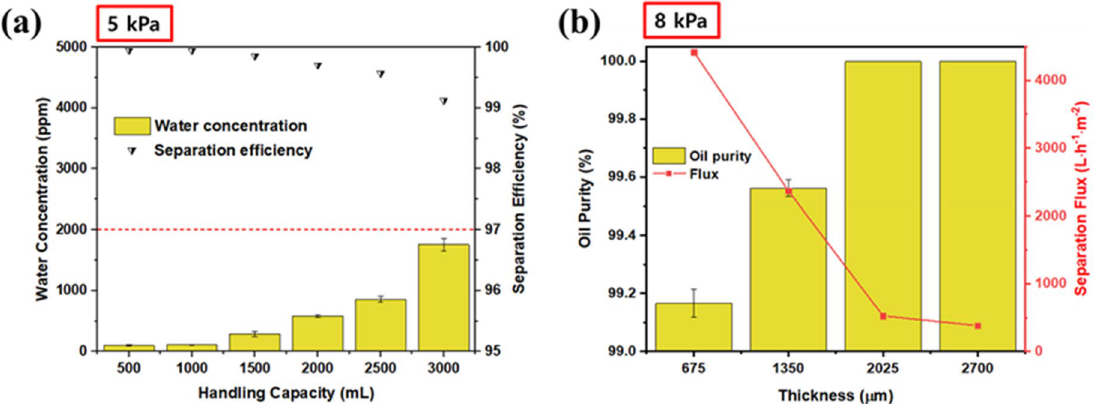
Figure 6. ( a ) Water concentration of separated oil and separation efficiency as a function of handling capacity for continuous separation. ( b ) Oil purity and separation flux of modified GMF membrane as a function of membrane thickness.